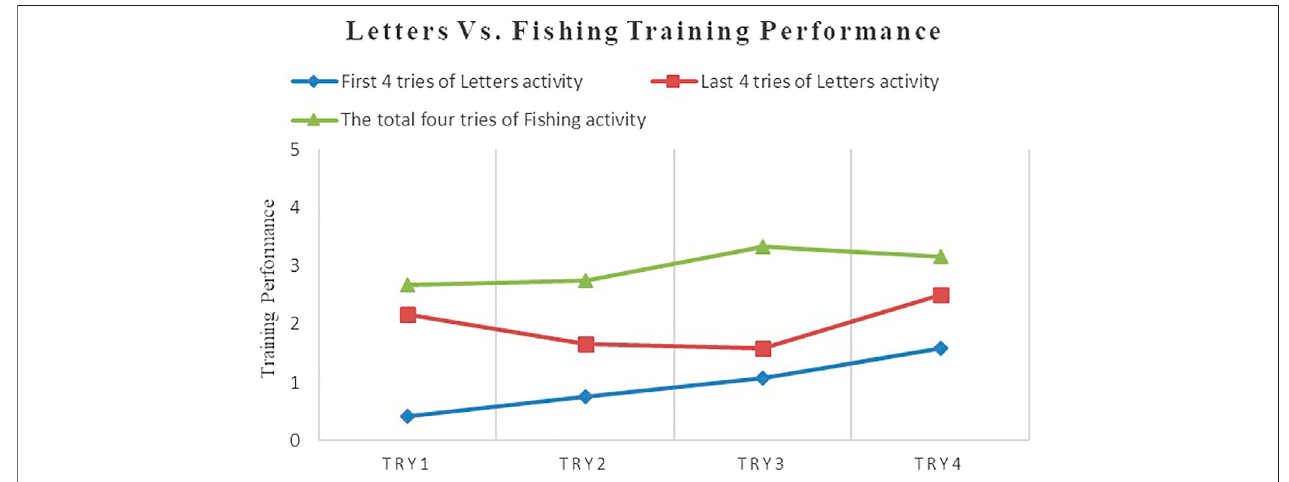
FIGURE10| Lettersvs.Fishing activity.Itdemonstratesthechildren ’ saveragescoresinthe fi rstandthelastfourtriesofLettersactivitycomparedtothechildren ’ s average scores in the total four tries of Fishing